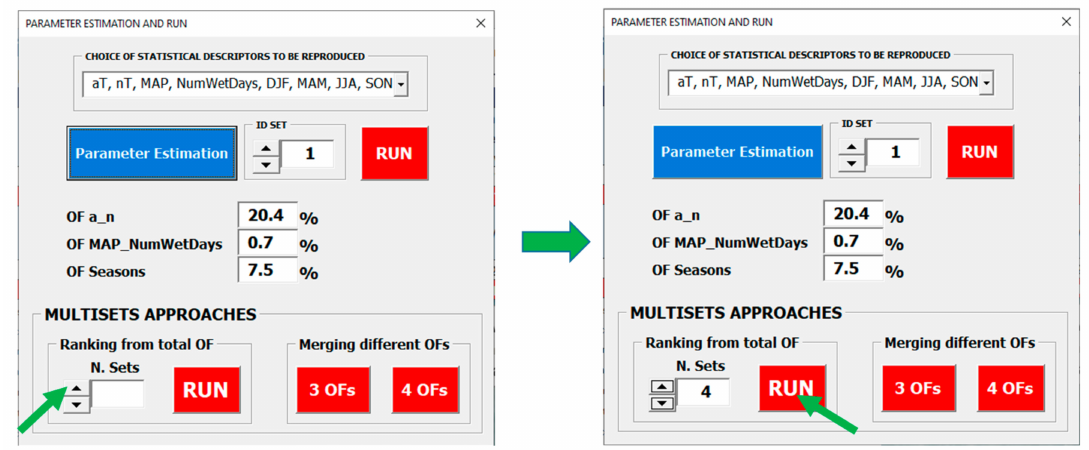
Figure 12. Example of multisets approach regarding the option “Ranking from total